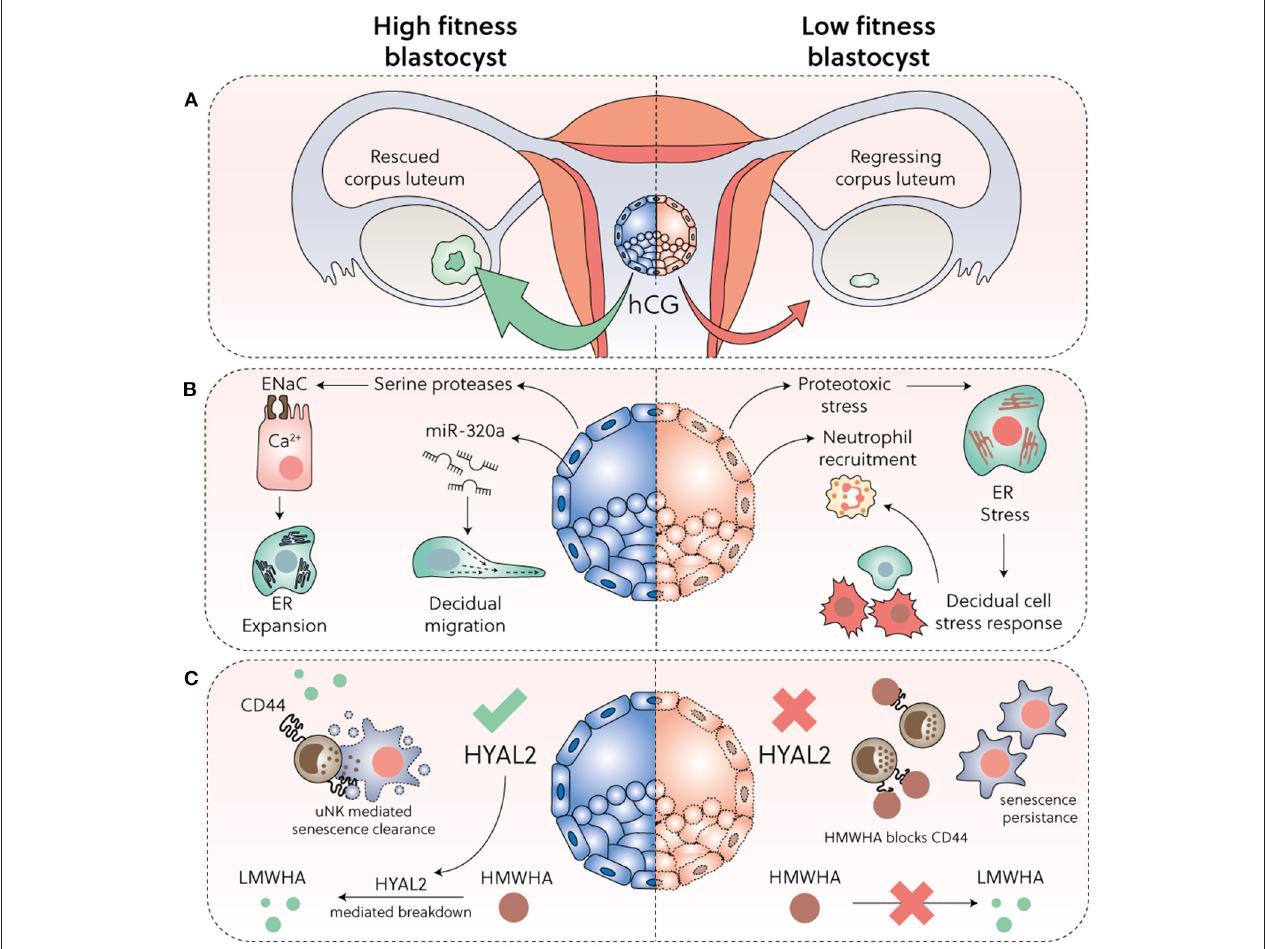
FIGURE 2 | Embryo biosensing and selection. (A) Sufficient hCG secretion from implanting blastocysts is required to prevent corpus luteum involution. (B) High-fitness human blastocysts elicit a supportive decidual response, including secretion of evolutionary conserved serine proteases that activate epithelial Na + channel (ENaC) expressed on luminal epithelial cells, triggering Ca 2 + signalling, ER expansion and subsequent induction of implantation specific genes. Further, by secretion of microRNA miR-320a, competent blastocysts promote migration of pre-decidualizing cells. Conversely, low fitness embryos trigger a decidual ER stress response, repression of key implantation factors, and secretion of CXCL12 and CXCL8 leading to neutrophil recruitment and activation. (C) HYAL2 production in developmentally competent blastocysts cleaves HMWHA into LMWHA, which supports further development. Loss or reduction of HYAL2 in low-fitness embryos promotes HMWHA accumulation, which binds to CD44 expressed on uNK cells and disables selective killing of